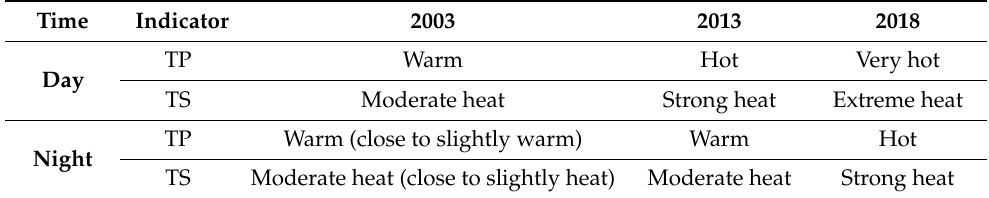
Table 5. Thermal perception (TP) and thermal stress (TS) during the daytime and nighttime from 2003 to 2018.